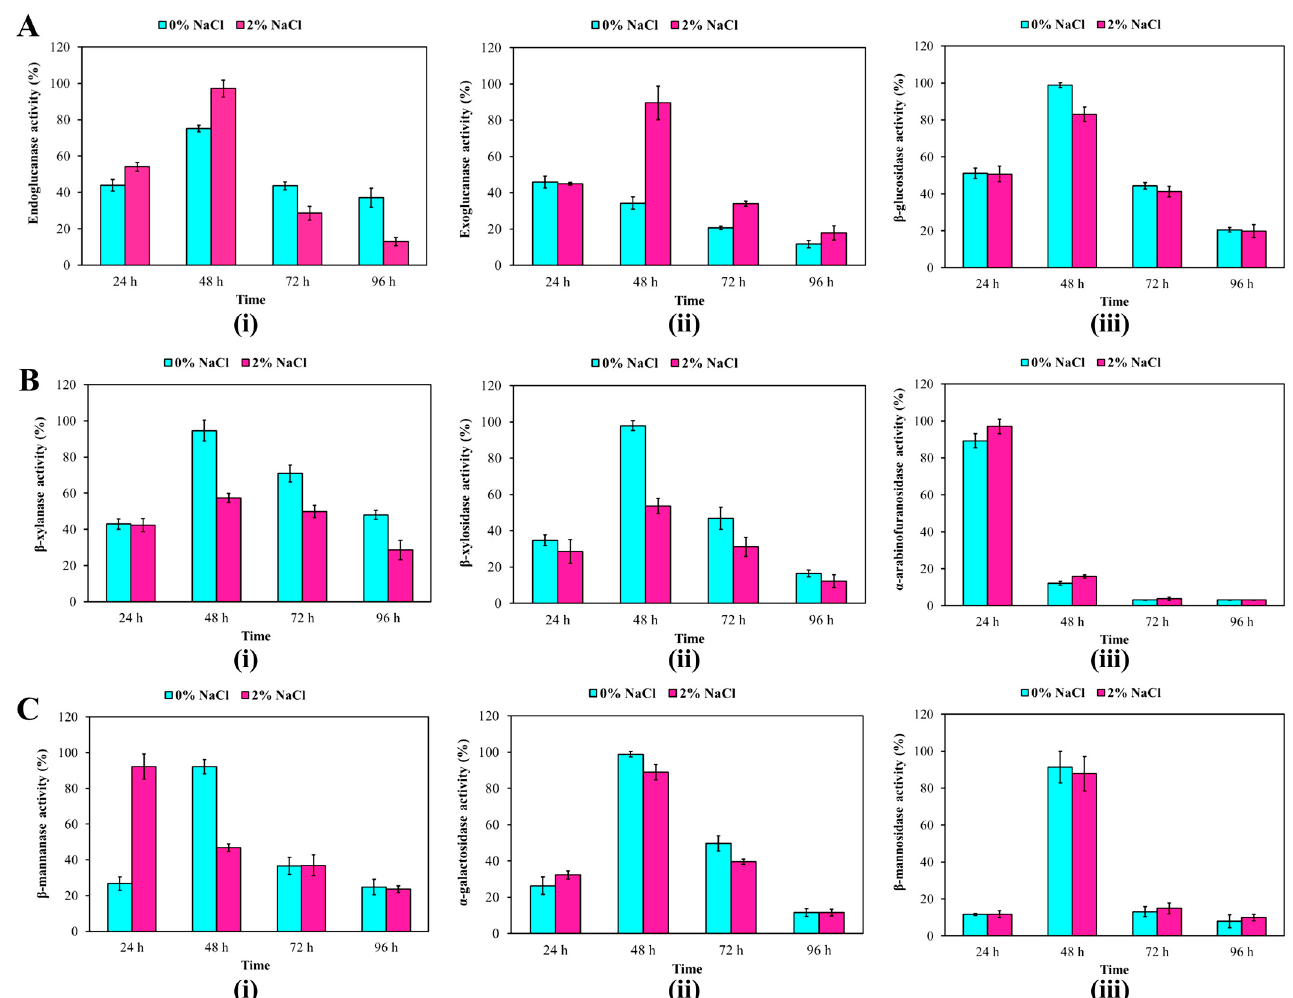
Figure 3. Cellulase ( A ), xylanase ( B ) and mannanase ( C ) activities of R. solimangrovi across 96 h of incubation with EFB. Enzyme relative activity (%) was calculated by relative to the case of reaction at which maximum activity was taken as 100%. Mean values ( n = 3) are expressed, and standard deviations are indicated as error bars. Significant differences ( p < 0.05) were examined by using student t -test.